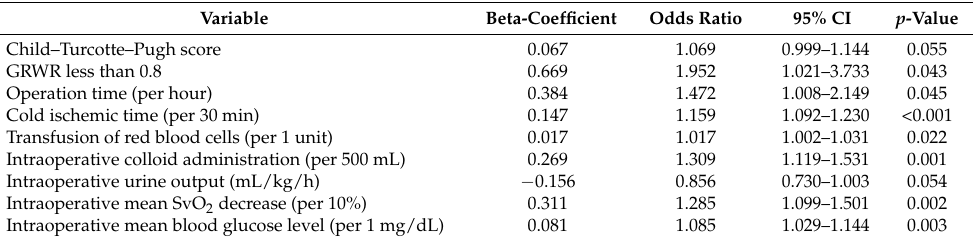
Table 3. Results of multivariable logistic regression analysis for acute kidney injury.